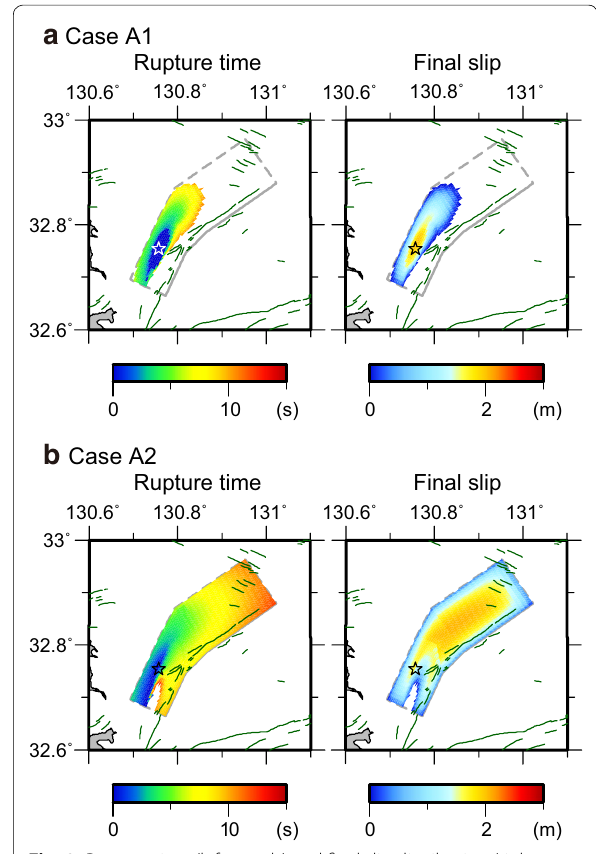
Fig. 8 Rupture time (left panels) and final slip distribution (right panels) in cases a A1 and b A2 without the free